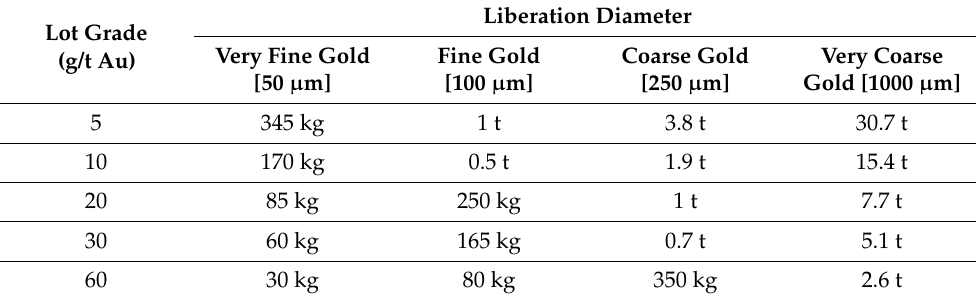
Table 3. Potential FSE-optimised sample mass for a fine- to coarse-gold ore based on achieving a precision of ± 15% at the 90% confidence limit. In this contribution the following values are used for all FSE equation parameters, as follows: alpha = 1.5; f = 0.30; g = 0.25; gold fineness = 850; d n = 10 cm, with values generally between 5 cm and 10 cm. Grade and liberation diameter values are given in this table. The residue d n is taken as 10